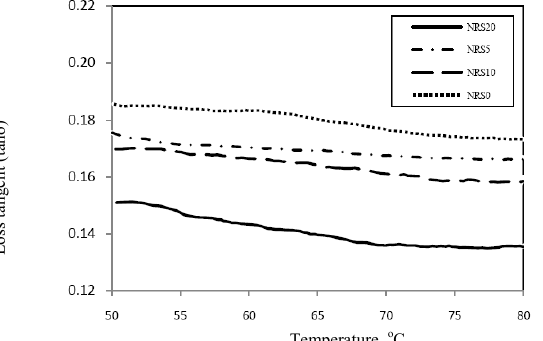
Figure 12 . DMTA graph of samples at various silica ratios.